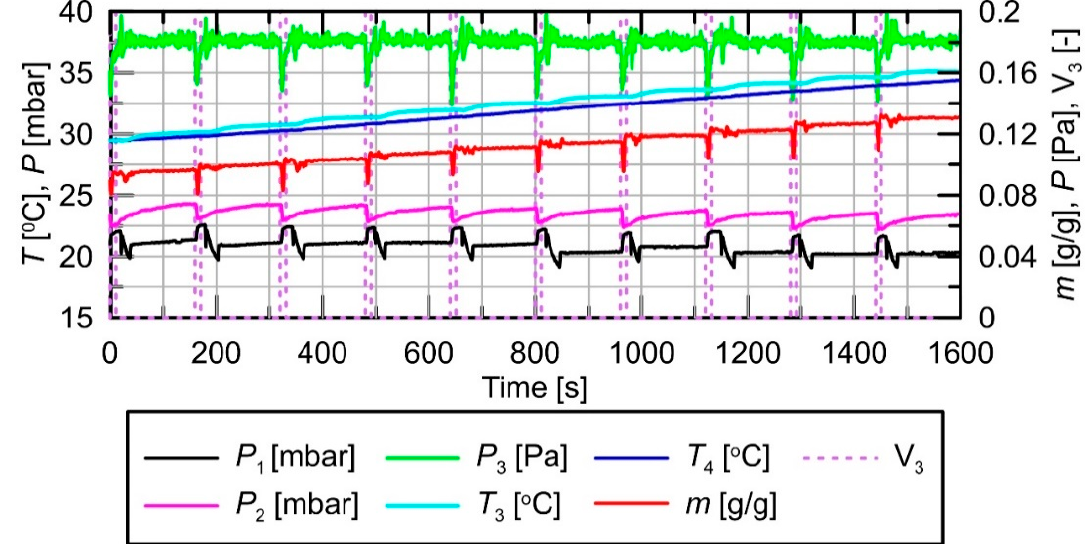
Figure 3. An exemplary result of the experimental test for the mixture 85%SG + 15%Al stationary state for ten consecutive cycles of valve V 3 opening and closing.